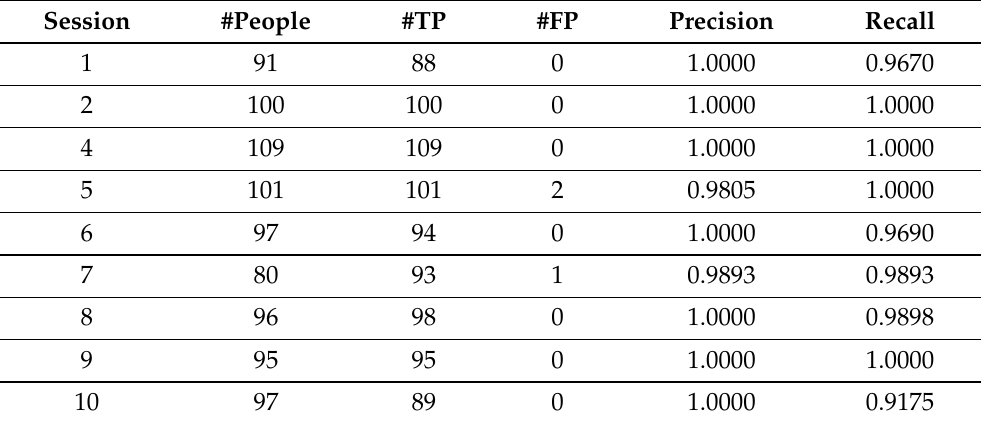
Table 2. Detection results of the proposed method.